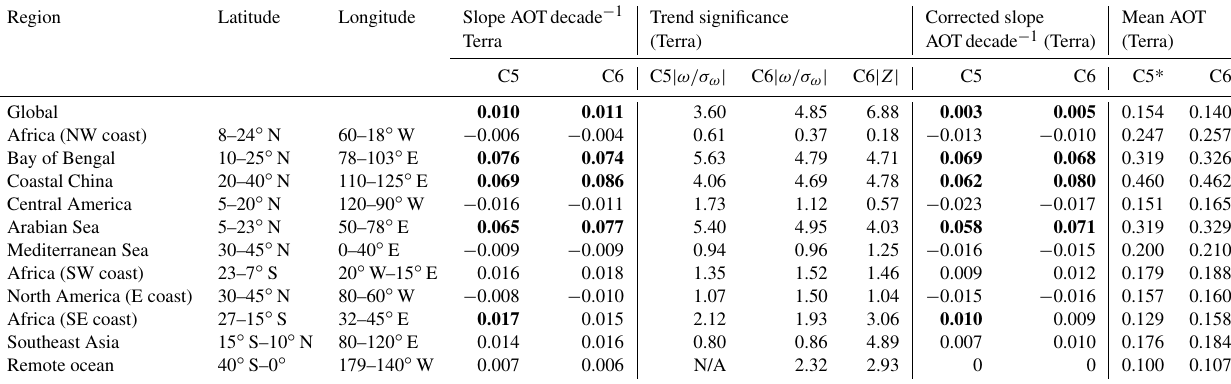
Table 2. AOT trend analyses for global and selected regions as suggested from Zhang and Reid (2010). Both trends from Collection 5 (C5, Zhang and Reid, 2010) and Collection 6 (C6) over-water Terra MODIS AOT data are shown for the study period of 2000–2009. The trend significances are derived using two different methods ( | ω/σ ω | and | z | values as estimated with the Weatherhead and Mann–Kendall methods, respectively). The corrected slopes refer to the slopes after accounting for the changes over the remote-ocean region. AOT trends and trend significances for C5 MODIS DT data are obtained from Zhang and Reid, (2010), which are derived using data-assimilation quality C5 MODIS DT data. For illustration purposes, C5* and C6 Terra MODIS AOT values, derived using similar methods as mentioned in this study, are also listed. C5* MODIS DT AOTs listed here are not from the same data-assimilation quality products as used in Zhang and Reid (2010). NW coast, SW coast, SE coast and E coast refer to the northwest coast, southwest coast, southeast coast and east coast, respectively. Note that, in this paper, SW means “southwest” when referring to a geographical area and “shortwave” when referring to flux. Region